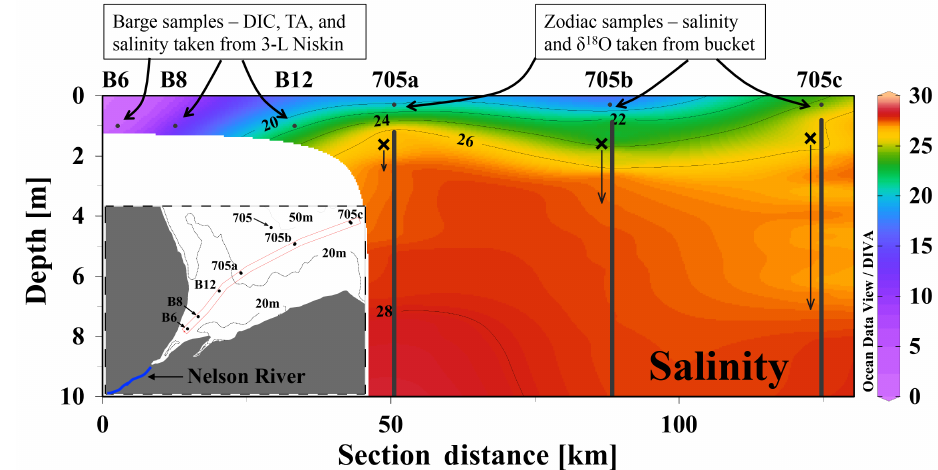
Figure 5. Salinity cross section (top 10m) in the Nelson River estuary (NRE). Location of transect is shown by the inset map in the lower right (see Fig. 1 for location of the NRE within Hudson Bay). Vertical black lines represent CTD profiles, while black dots (depths ≤ 1m) represent samples taken independently using the single 3L Niskin ( ∼ 1m depth, stations B6, B8, B12) and samples taken using the bucket ( ∼ 0.3m depth at stations 705 a, b, c). Black X’s show the depth where surface Niskin bottles were closed, as recorded by the CTD’s pressure sensor, while the black vertical arrows extend to the depth where salinities in the Niskin bottles match the salinity recorded by the CTD. Prior to closing each Niskin bottle, the rosette was held at the target depth for 1min to allow for adequate flushing and stabilization (Y. Gratton, personal communication, 2016). At all three rosette stations (705 a, b, c), Niskin bottle salinities are markedly higher than the CTD salinities at the closure depth, suggesting that higher-salinity waters were entrained into surface waters by the rosette